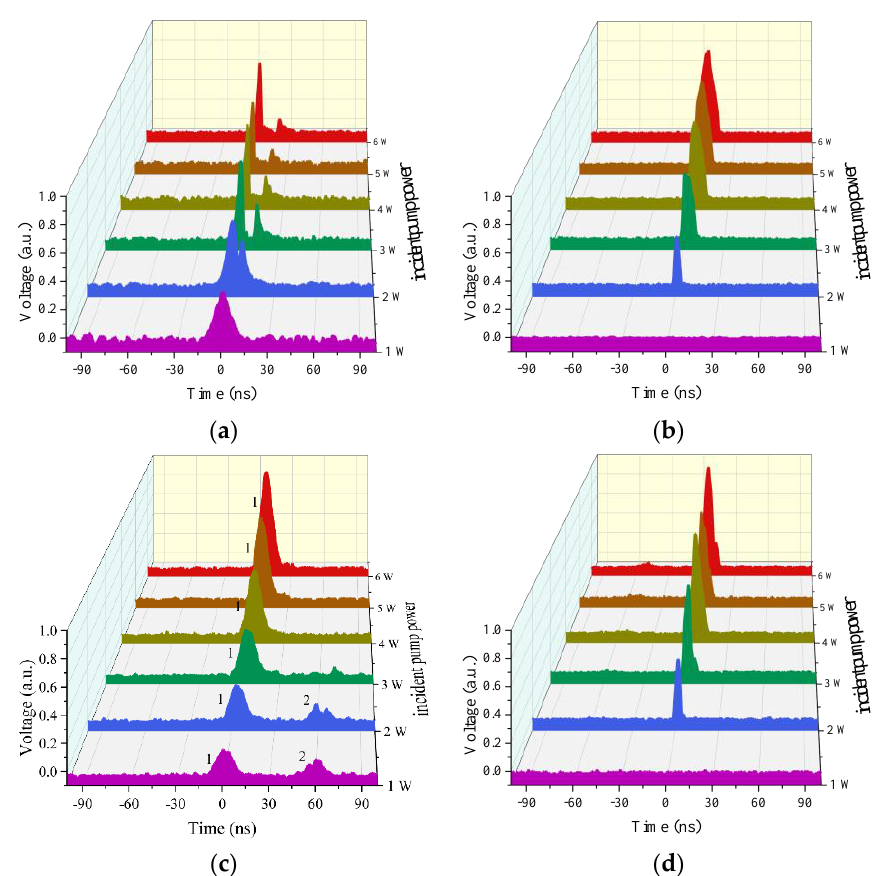
Figure 3. The output pulse shapes of ( a ) the forward pump laser, ( b ) the forward Raman laser, ( c ) the backward pump laser, and ( d ) the backward Raman laser.